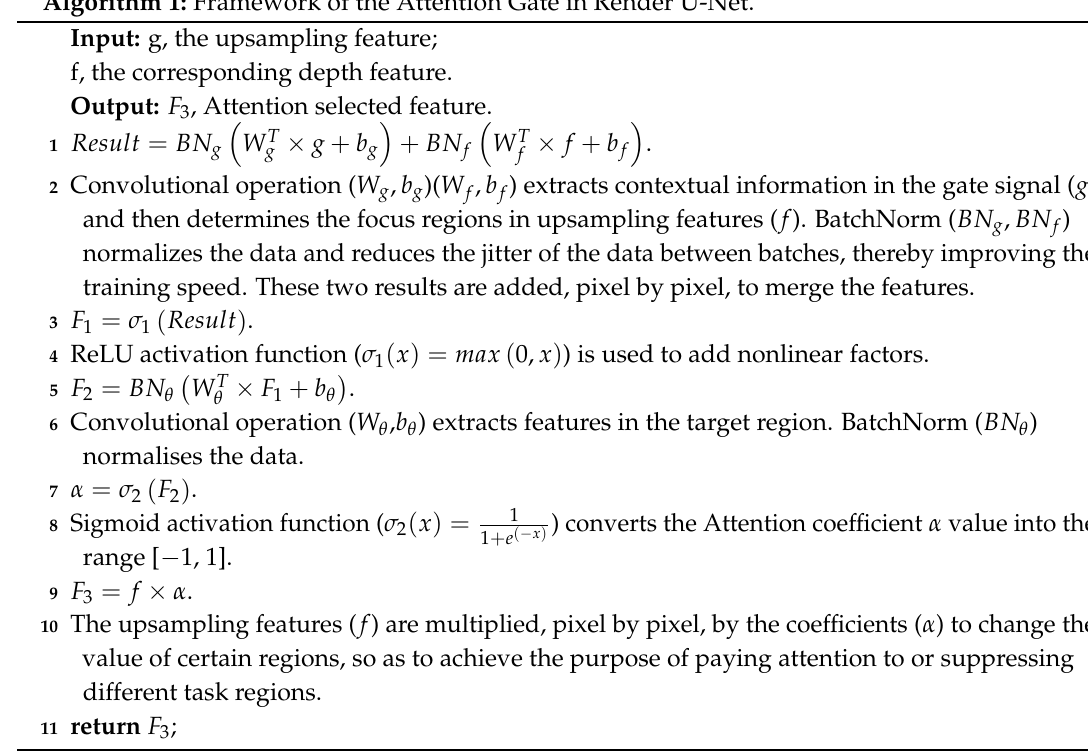
Algorithm 1: Framework of the Attention Gate in Render